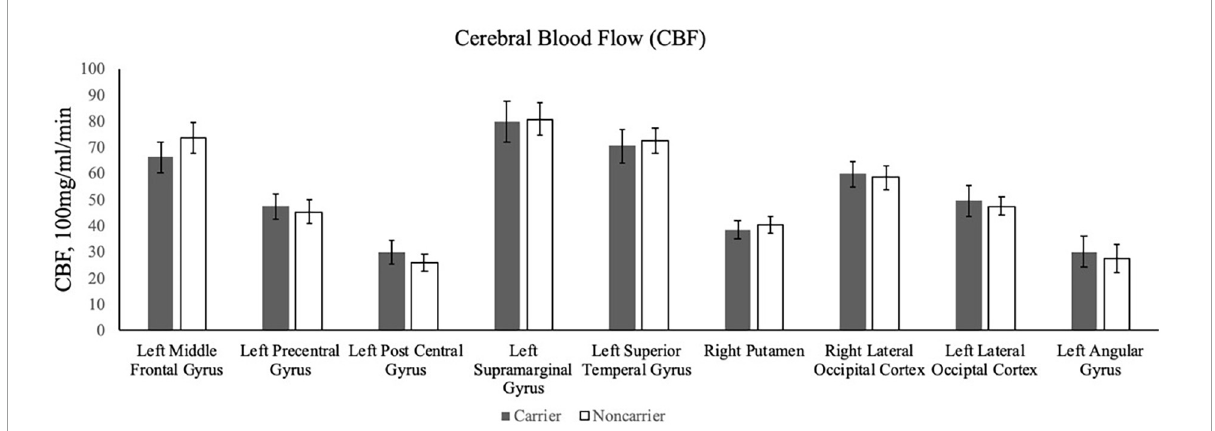
FIGURE2 The bar graphs display mean CBF for the ε 4 carriers and non-carriers in the ROIs derived from the whole-brain analysis of the n-back